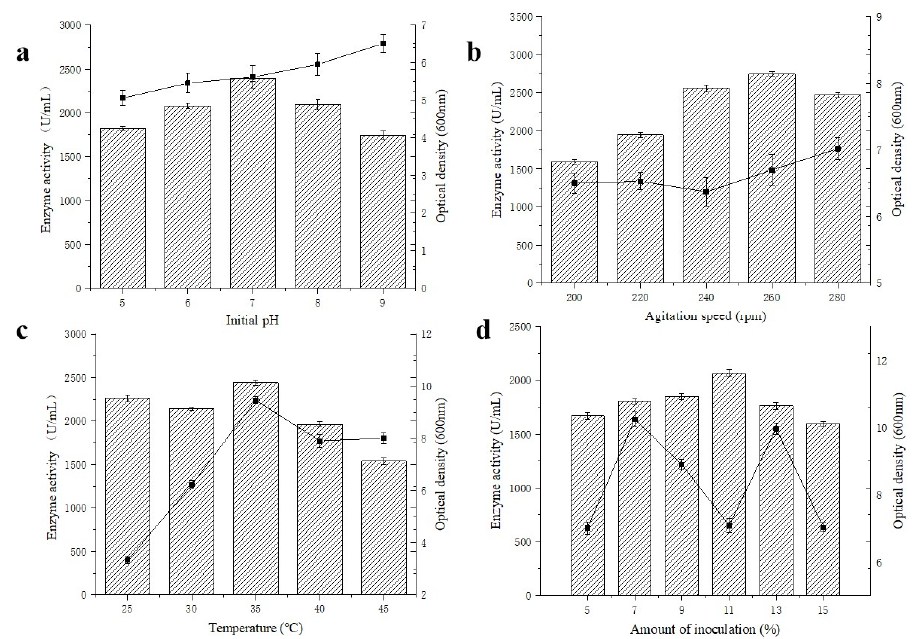
Figure 8. Optimization of the expression conditions for producing collagenase in B. subtilis WB600. Histogram, the activity of recombinant collagenase. Line, bacterial cell growth. ( a ) Effect of initial pH on the collagenase activity and bacterial cell growth. ( b ) Effect of agitation speed. ( c ) Effect of expression temperature. ( d ) Effect of inoculation percentage. The data are presented as mean ± standard deviation from three independent experiments.